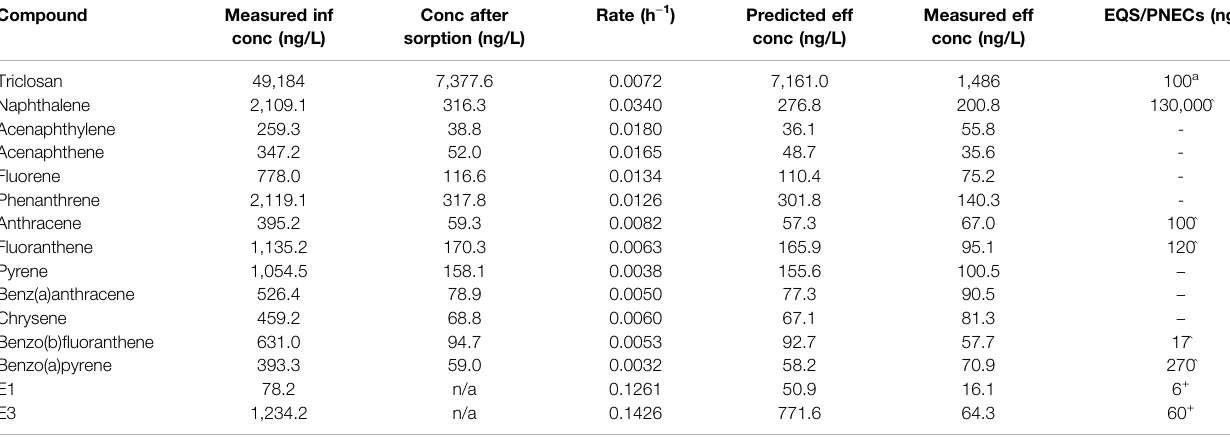
TABLE 3 | Predicted ef fl uent concentration of the chemicals after activated sludge treatment (Brazil WWTP A). Compound Measured inf conc (ng/L)